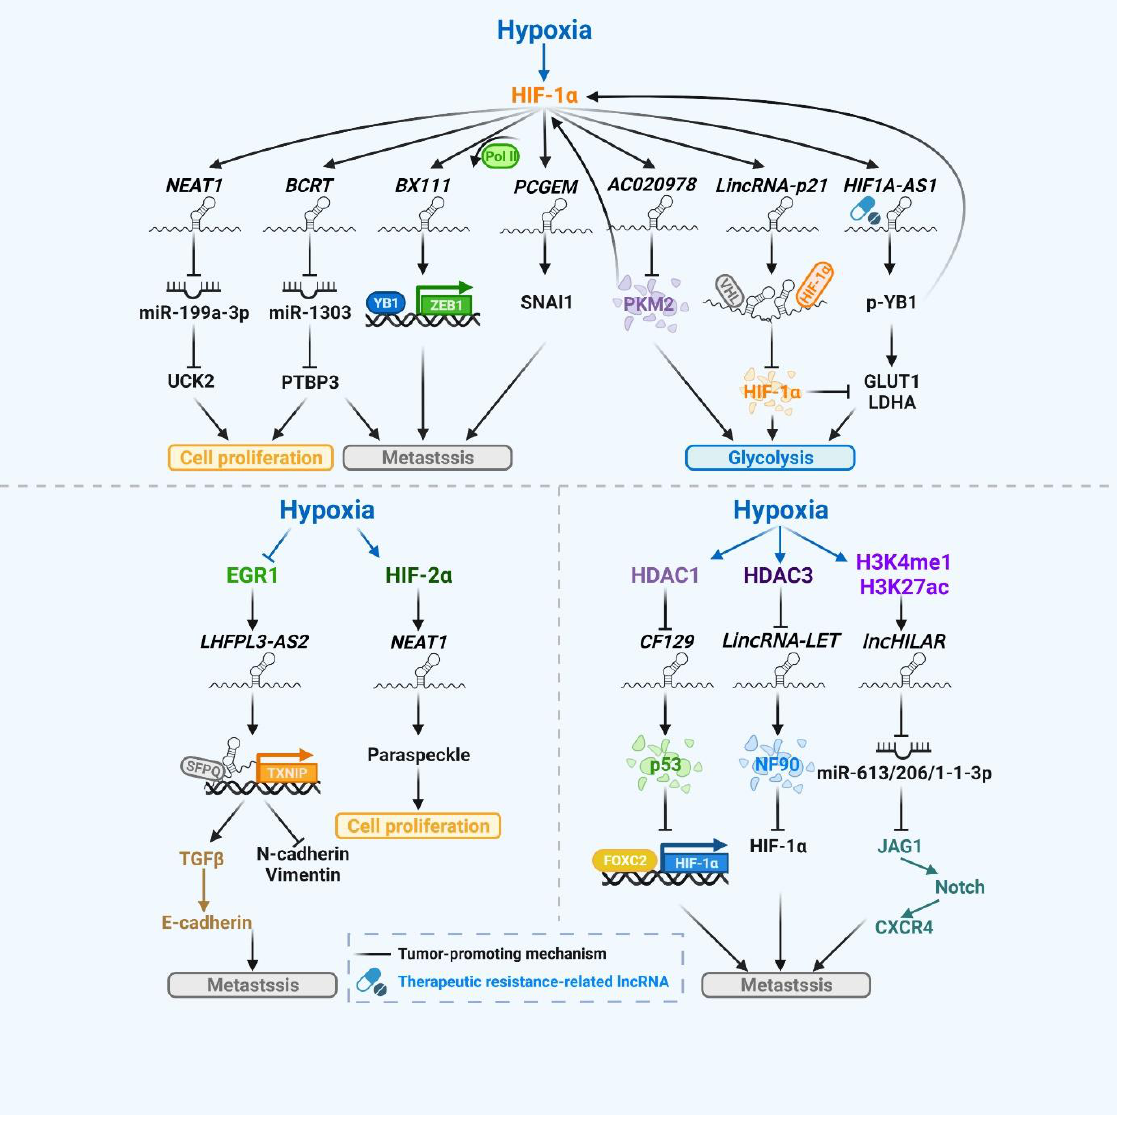
Figure 2. LncRNAs involved in the hypoxic stress response are regulated through both transcriptional control and epigenetic modification. Upon hypoxia, lncRNAs are regulated by not only specific transcription factors such as HIF- 1α, HIF - 2α and EGR1 but also hypoxia -dependent epigenetic modification. The regulated lncRNAs further turn on the tumor-promoting processes, including cell proliferation, metastasis and glycolysis to overcome the hypoxic stress. BCRT (breast cancer-related